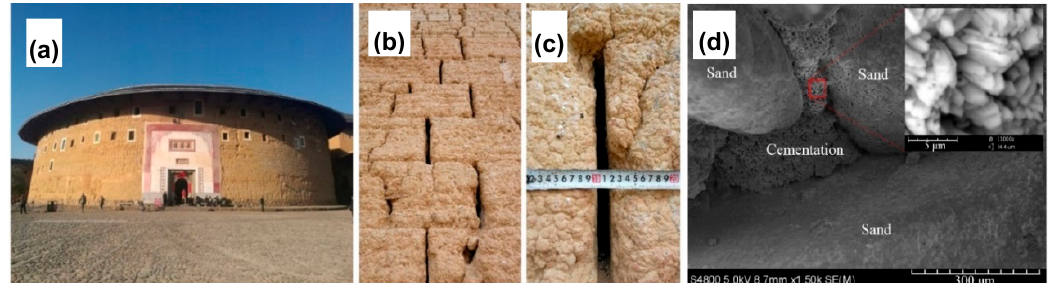
Figure 11. Photographs of ( a ) The King of Tulou – Chengqilou, ( b ) and ( c ) wall deteriorated cracks (width is approximately 1.5 cm, depth is up to 100 cm). ( d ) SEM images of samples after MICP treatment. Adapted with permission from [86] 2020, Elsevier.